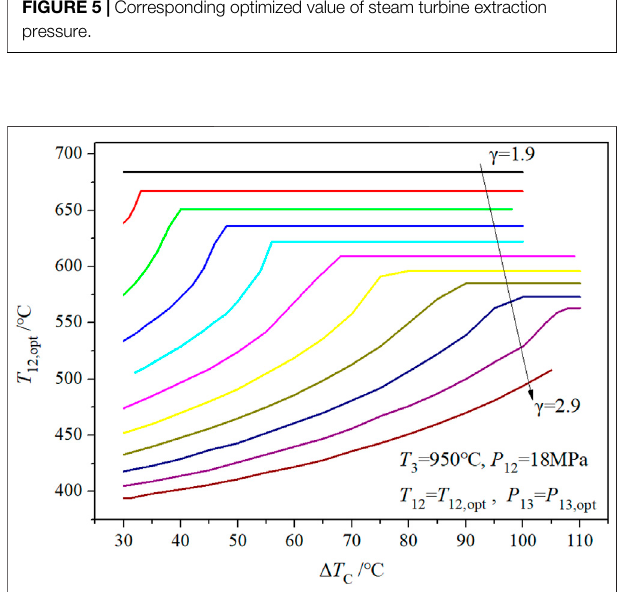
FIGURE 6 | Corresponding optimal value of main steam